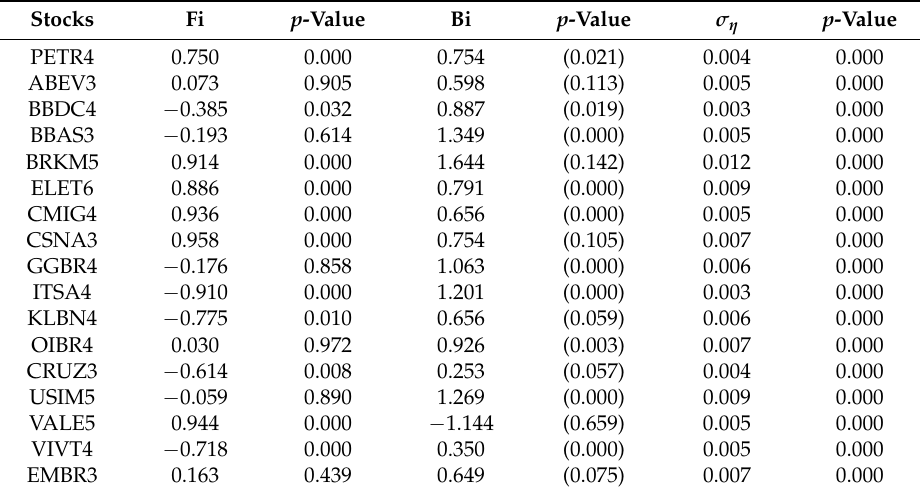
Table A2. Coefficients of the model with price variables.